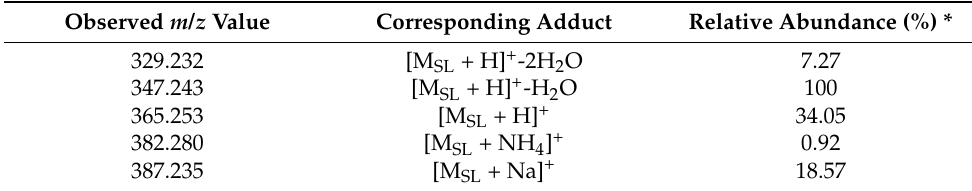
Table 4. Adducts determined from the observed m/z obtained via ElectroSpray Ionization- Quadrupole (ESI-Q) experiment for the purified Sorbitol-6- O -Laurate (SL).